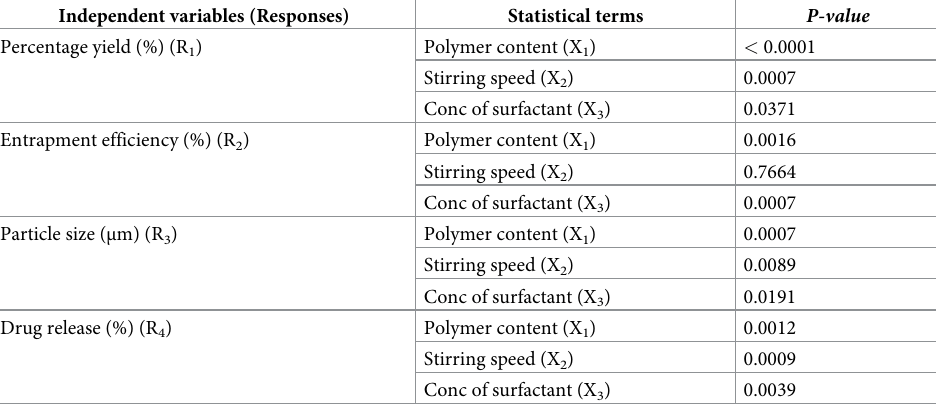
Table 3. ANOVA analysis values of independent